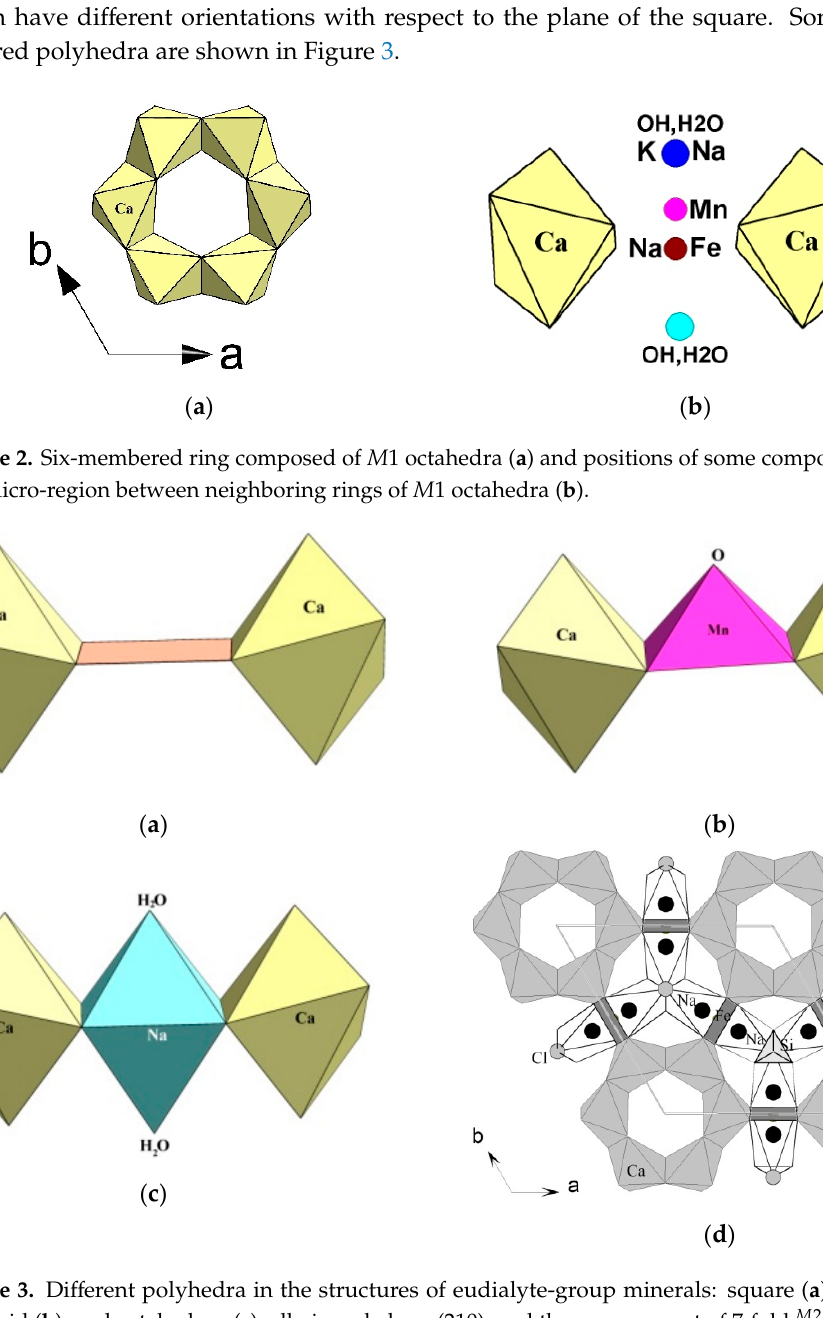
Figure 3. Different polyhedra in the structures of eudialyte-group minerals: square ( a ), tetragonal pyramid ( b ), and octahedron ( c ), all viewed along (210), and the arrangement of 7-fold M 2 Na-centered polyhedra in a high-sodium EGM [28] ( d ).